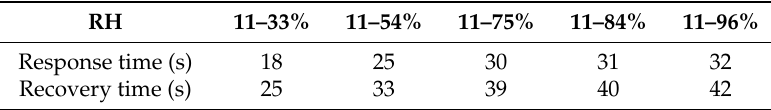
Figure 6. Response/recovery time of the SnO 2 nanostructure sensor from 11% RH to 96% RH. Table 1. The response/recovery time of the SnO 2 nanostructure Table 1. The response/recovery time of the SnO 2 nanostructure sensor. Table 1. The response/recovery time of the SnO 2 nanostructure sensor.